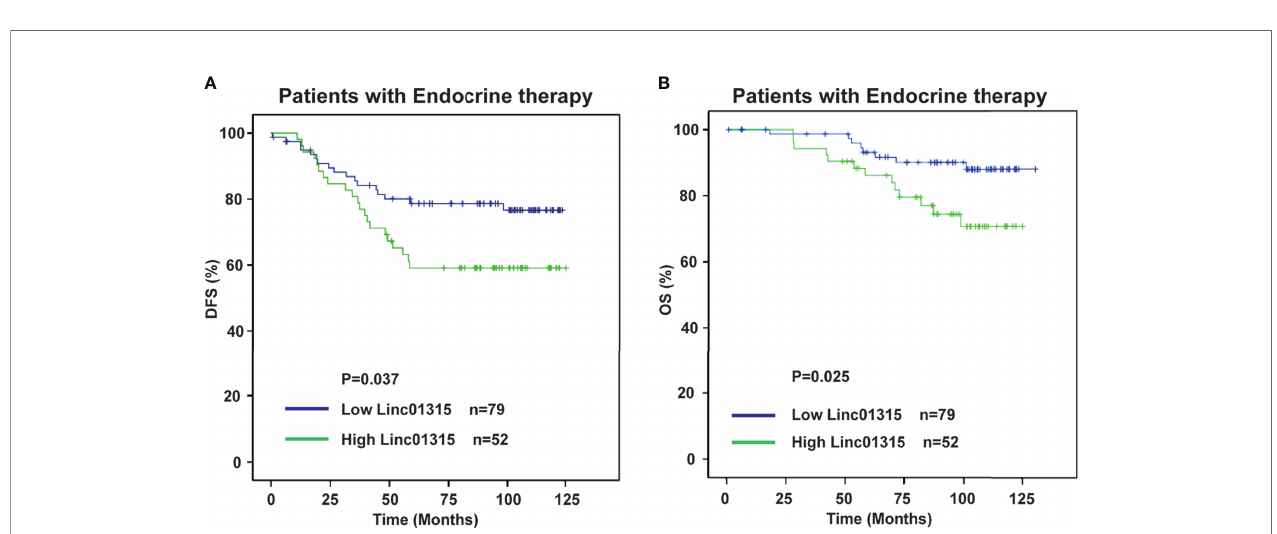
FIGURE 5 | Low Linc01315 level patients with endocrine therapy could bene fi t patients DFS and OS. (A) DFS curve of patients treated with endocrine therapy based on the level of Linc01315. (B) OS curve of patients treated with endocrine therapy based on the level of